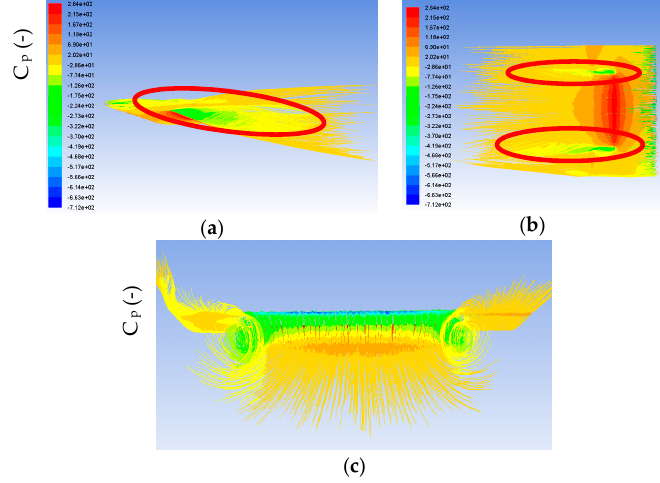
Figure 13. The pressure coefficients of the flow over a conventional wing aerofoil, vortices indicated in red circle, 0-degree angle of attack ( a ) Side view; ( b ) Top view; ( c ) Rear View.